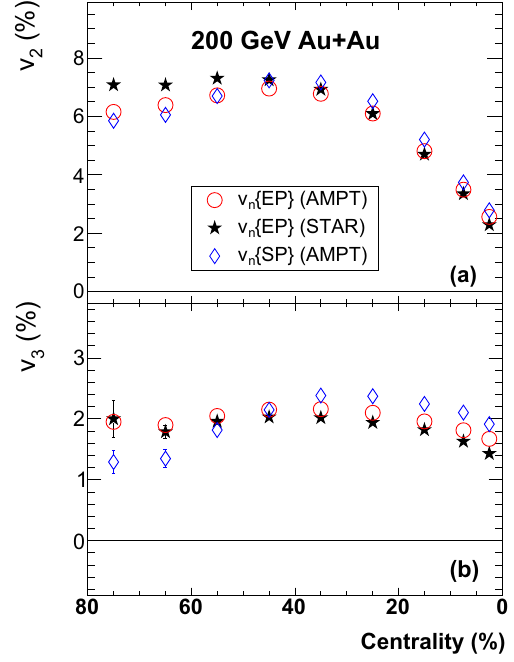
Fig. 1 Centrality dependence of elliptic flow, v 2 (upper) and triangular flow, v 3 (lower) for AMPT and STAR results [32,33] in Au+Au colli- √ s NN = 200 GeV. Flow harmonics from AMPT are calculated sions at with the event plane and the scalar product